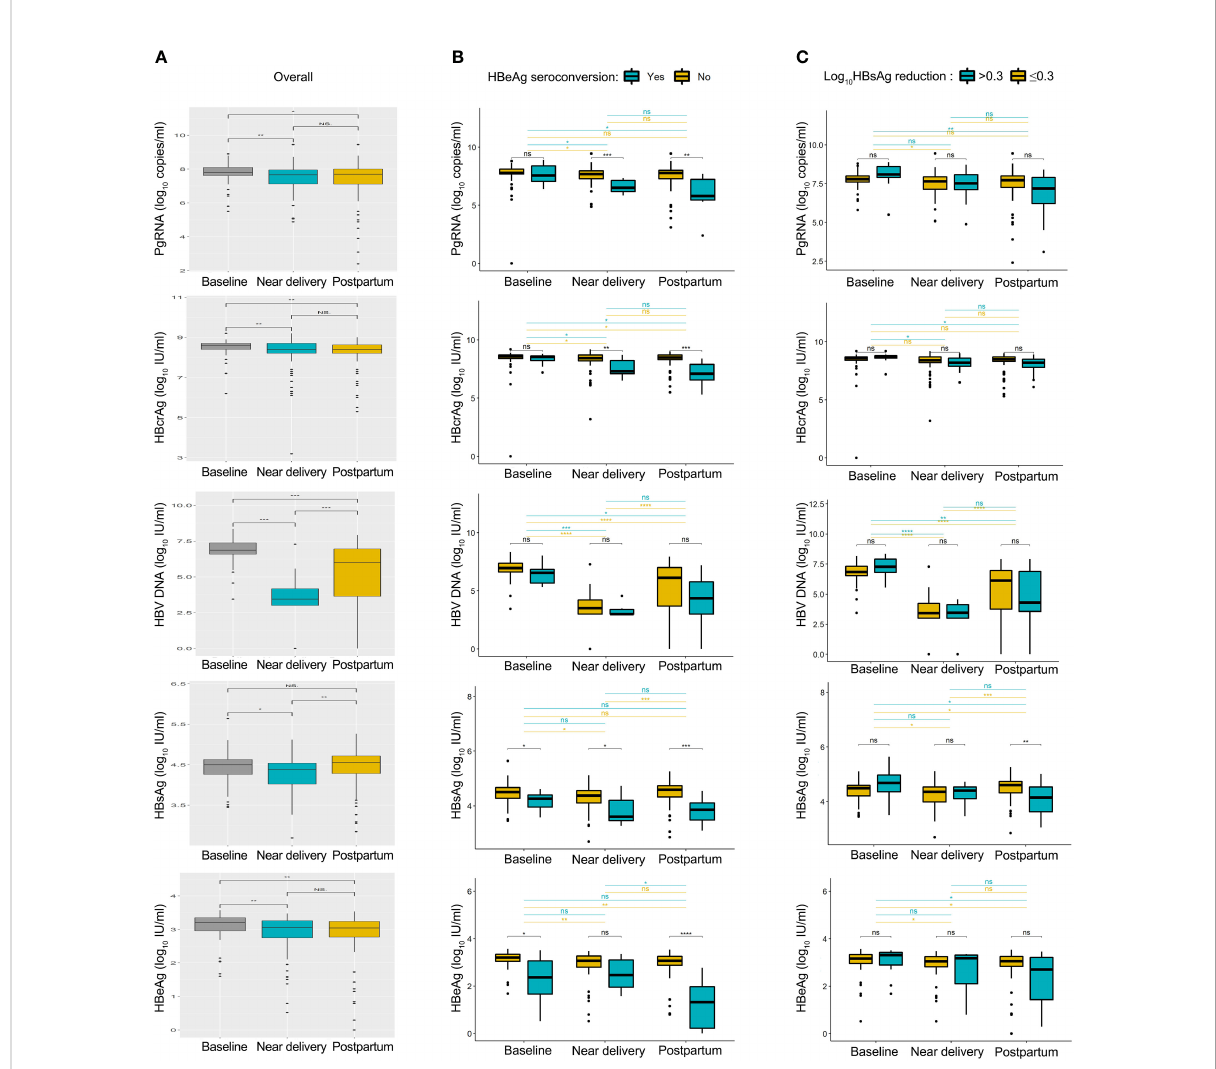
FIGURE 1 Summary of HBV biomarkers from baseline to postpartum. Kinetics of pgRNA, HBcrAg, HBV DNA, HBsAg and HBeAg levels was shown in all patients (A) , patients with or without HBeAg seroconversion (B) , patients with or without HBsAg reduction (C) . Baseline, 24-28 weeks of gestation; near delivery, 32-36 weeks of gestation; postpartum, at 2-6 weeks after delivery. NS = non-signi fi cant (p > 0.05), * P < 0.05, ** P < 0.01, *** P < 0.001, **** P <